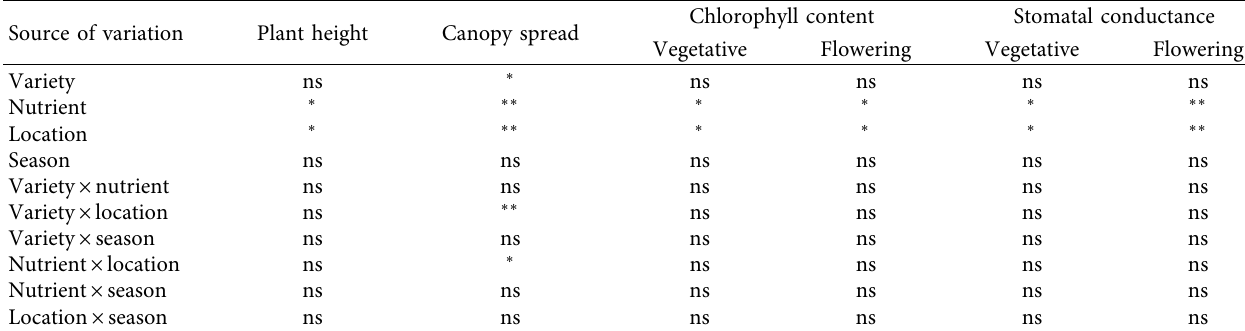
Table 2: Analysis of variance for treatment effects and their interactions on plant height, canopy spread, chlorophyll content, and stomatal conductance.